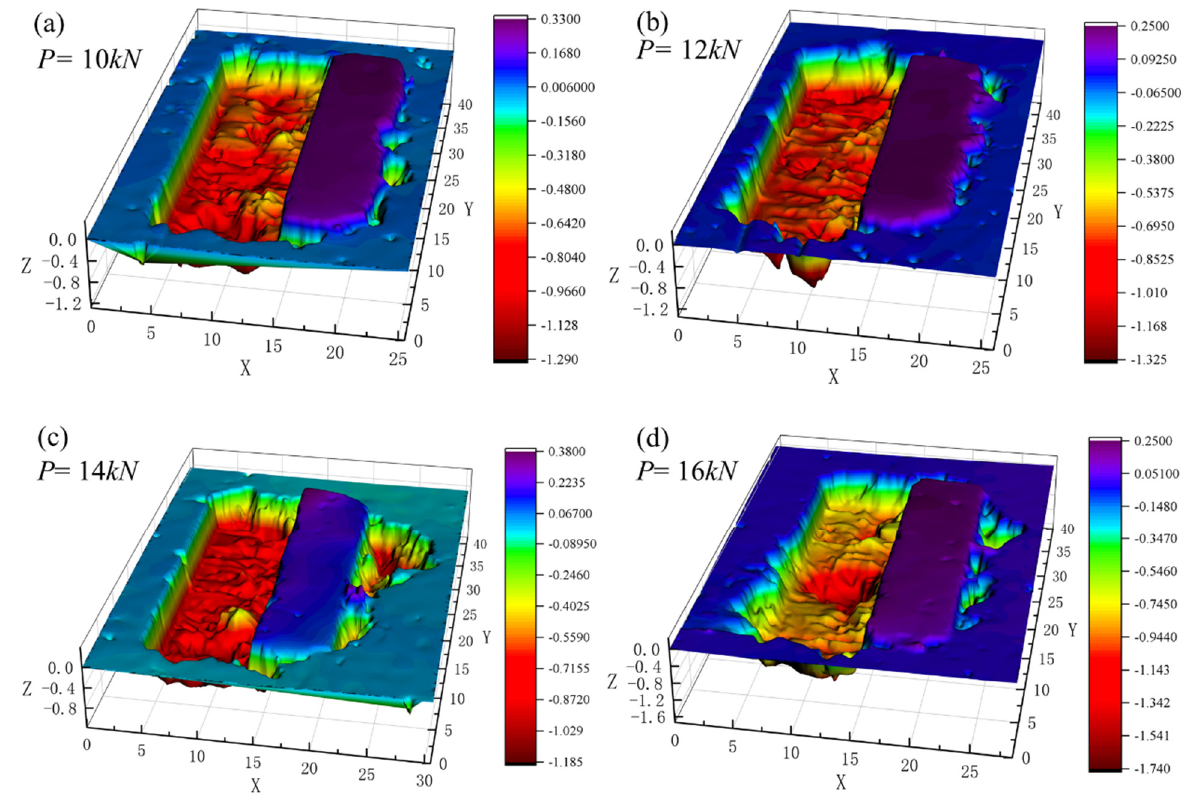
Figure 13. Scan of the shear surface of shear indenter 3: ( a ) P =1 0 kN ( b ) P = 12 kN ( c ) P = 14 kN ( d ) P = 16 kN.